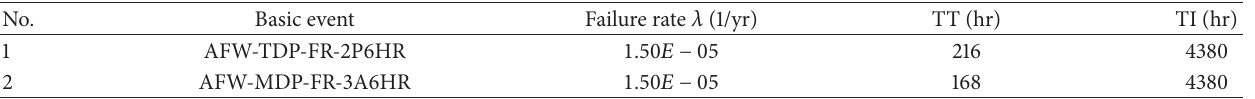
Figure 7: System unavailability of the AFW system over time for case scenario 2 with consideration of the Δ SET and time interval 𝑇 . Table 4: Basic events under maintenance in case scenario 1 with corresponding input data.